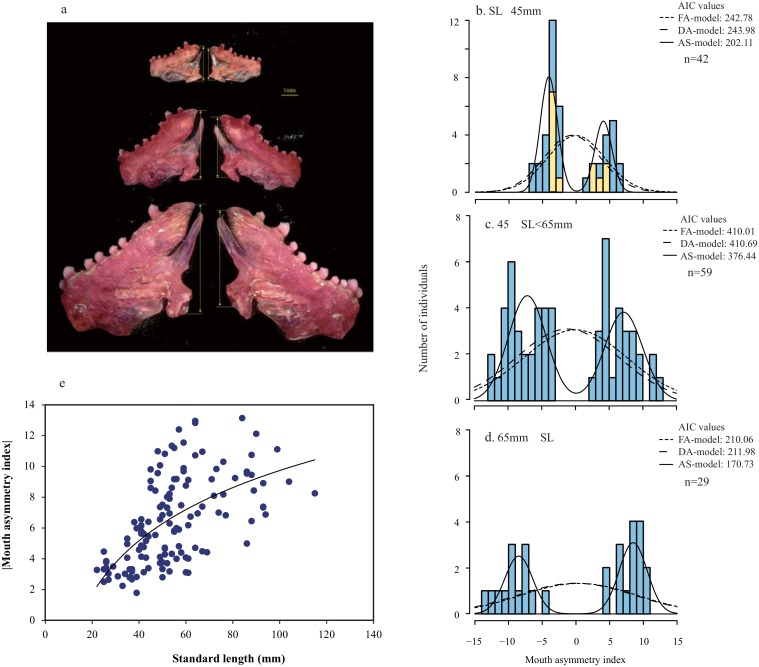
Development of mouth asymmetry in P. microlepis.a, The left and right lower jaw bones of three size classes of lefty P. microlepis (top: 38mm SL, middle: 64mm SL, bottom: 99mm SL). Arrow length represents the height of the entire posterior dimension of the lower jaw (PD height). The left jaws of each of these individuals were clearly larger than the right jaws. b, c, d, Frequency distributions of mouth asymmetry index. b, Small-sized fish. The yellow and blue columns represent plankton-feeding fish and omnivore-eating fish, respectively. c, Medium-sized fish. d, Large-sized fish. The lines indicate the probability curves derived from the three models: the FA-model (dotted line), DA-model (broken line), and AS-model (solid line). e, The relationship between body size (standard length) and the absolute value of mouth asymmetry index. The line indicates log-linear regression (y = 4.98ln(x)– 13.17, R2 = 0.361, P<0.001).